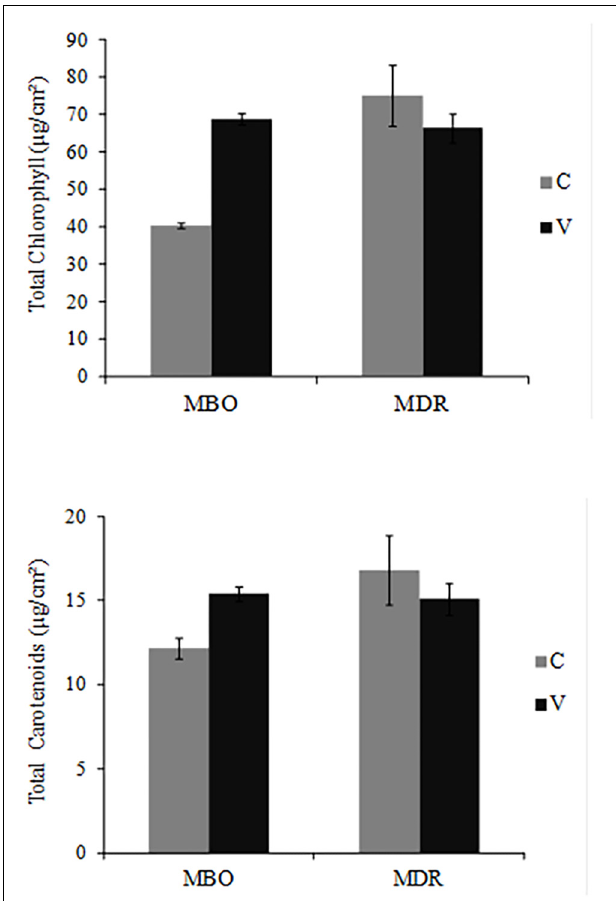
FIGURE 2 | Total chlorophyll (a + b) and total carotenoid (x + c) content in fully expanded leaves of Ranunculus asiaticus L. hybrids MBO and MDR, obtained by two preparation procedures of tuberous roots, only rehydration (Control, C) and rehydration followed by vernalization (V). Plants at vegetative stage (4th week after planting), grown in a climatic chamber under a controlled environment. Mean values ± standard errors; n =